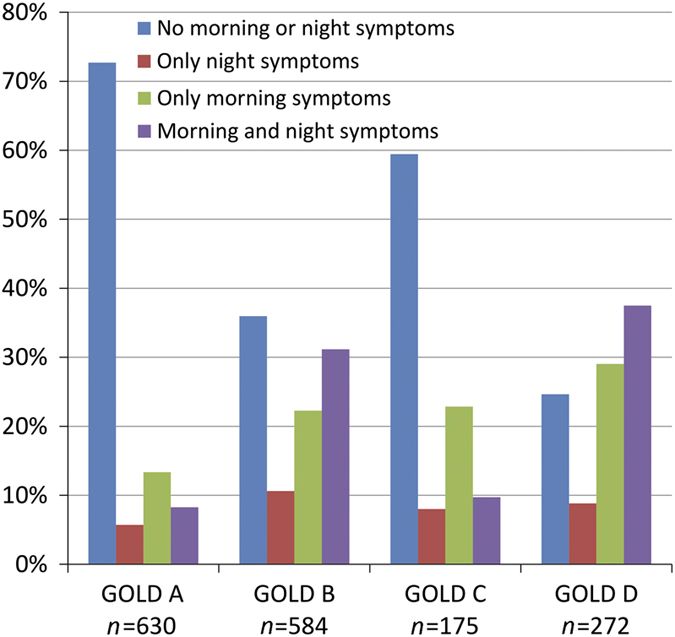
Percentages of patients with no morning and night symptoms, only night or morning symptoms and patients with both morning and night symptoms within the GOLD A,B,C,D categories.